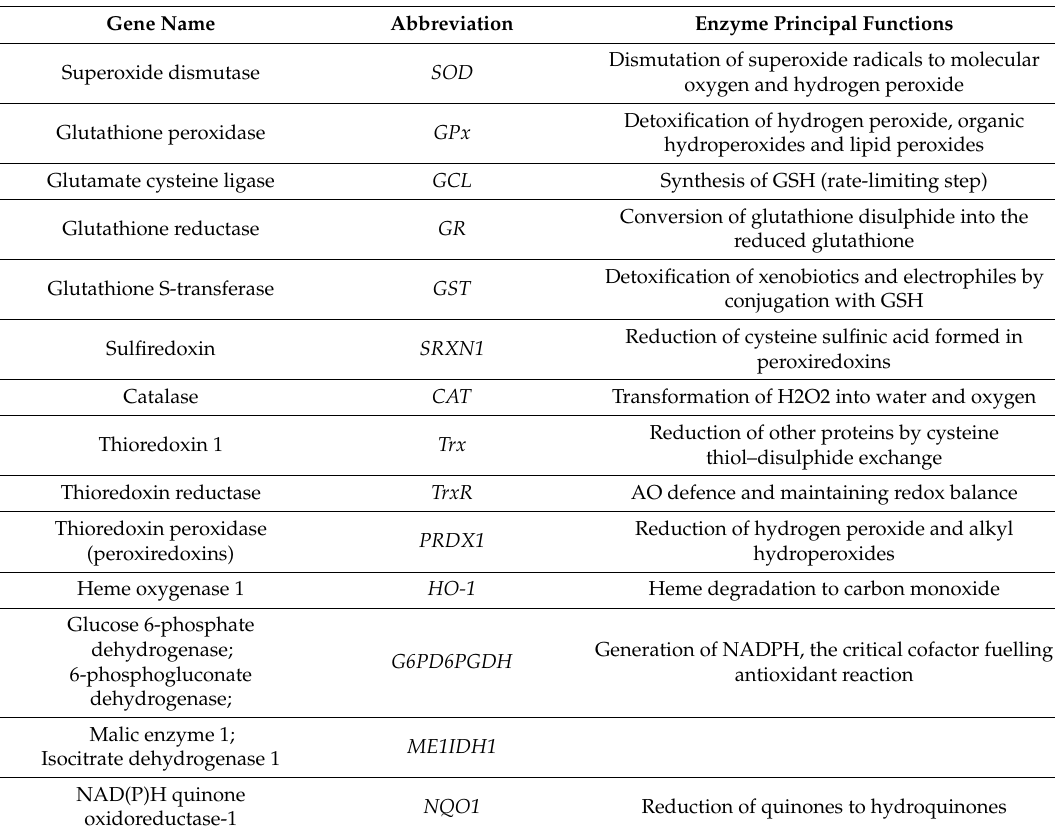
Table 3. Principal functions of enzymes encoded by Nrf2 target genes and involved in the antioxidant defence